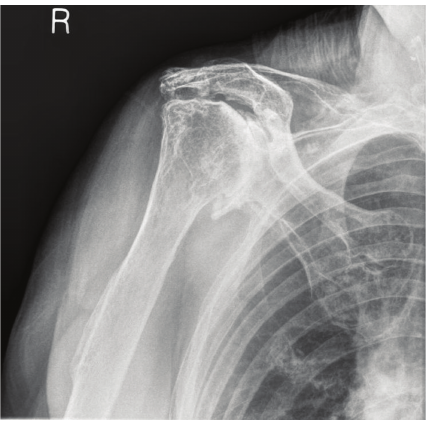
Figure 1: AP radiograph of the right shoulder taken preoperatively.